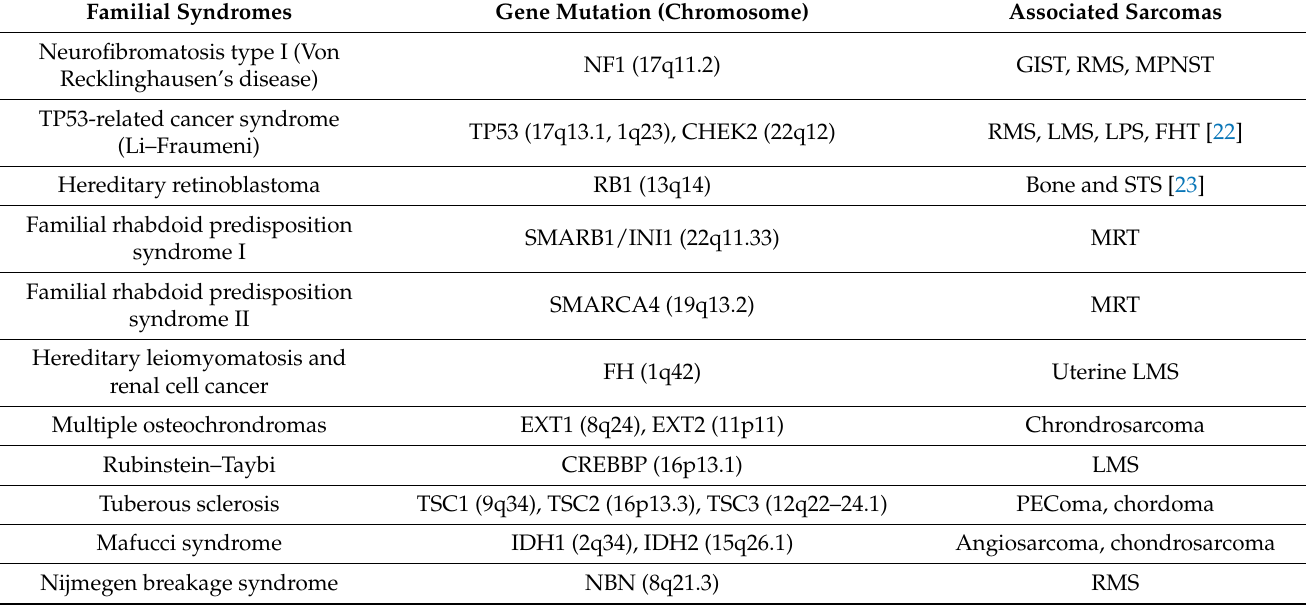
Table 2. Genetic syndromes associated with the development of soft-tissue